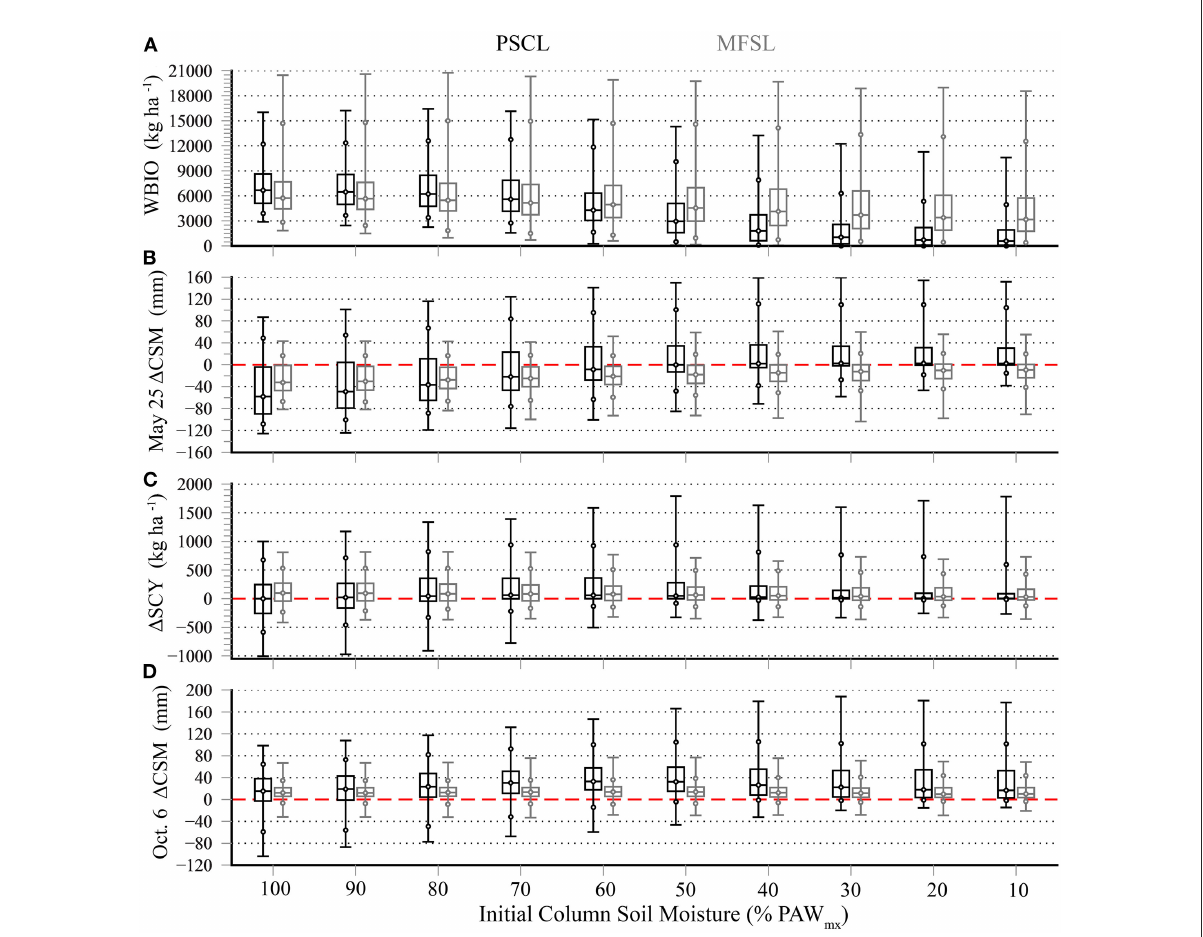
FIGURE7 (A) Distributions of PSCL MO 17 and MFSL MO 18 wheat biomass (WBIO) for initial fall column soil moisture conditions ranging from 100 to 10% of maximum plant available water (PAW mJ ). (B) As in (A) for PSCL and MFSL column soil moisture effects ( 1 CSM) at cotton planting. (C) As in (A) for PSCL and MFSL seed cotton yield ( 1 SCY). (D) As in (A) for PSCL and MFSL 1 CSM at cotton